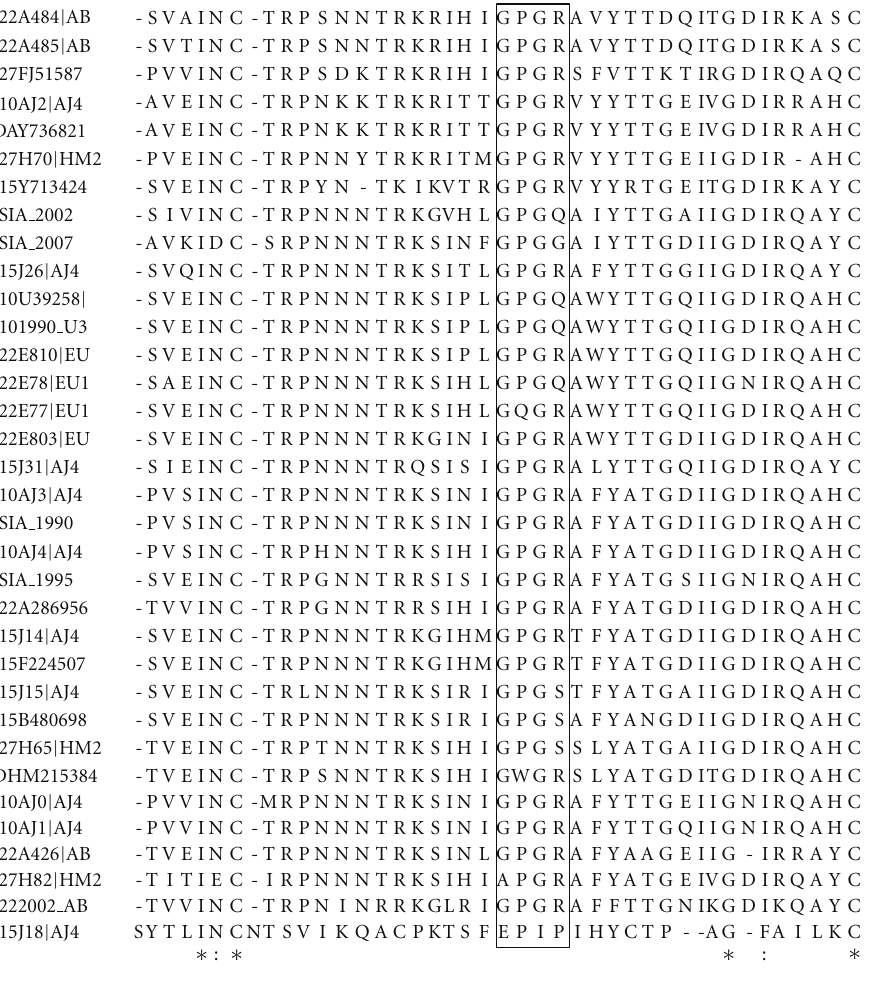
Figure 3: Multiple sequence alignment showing the variation a GPG X